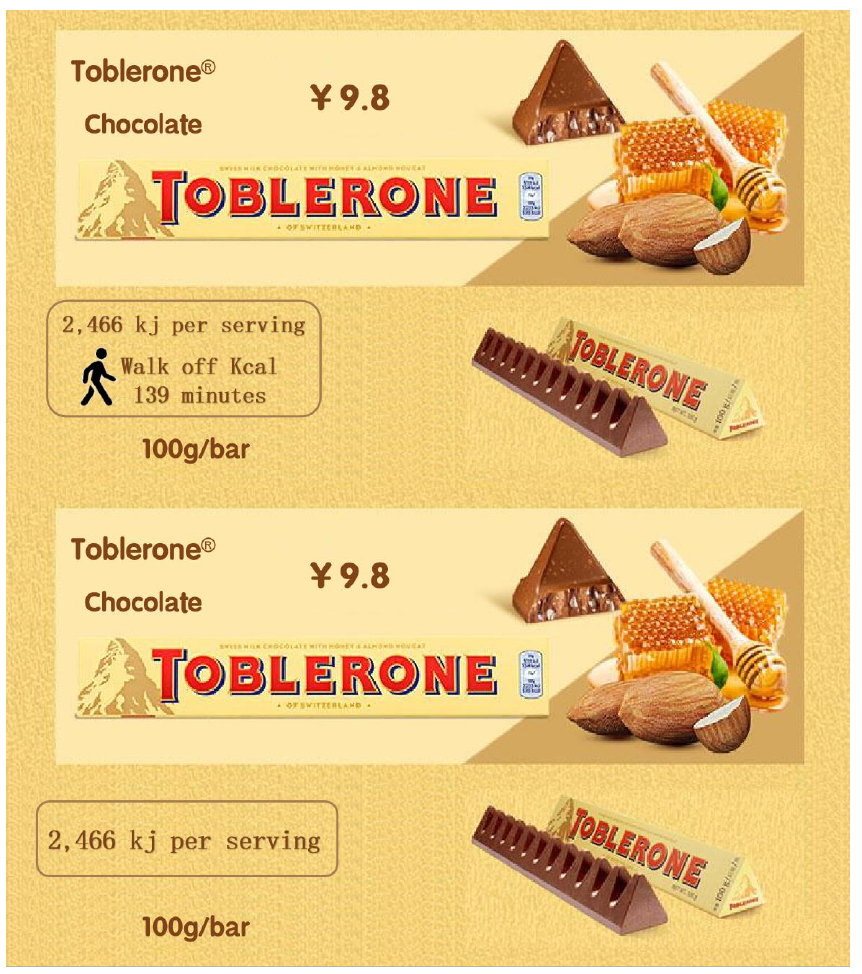
Figure 6. Stimuli of study 2.